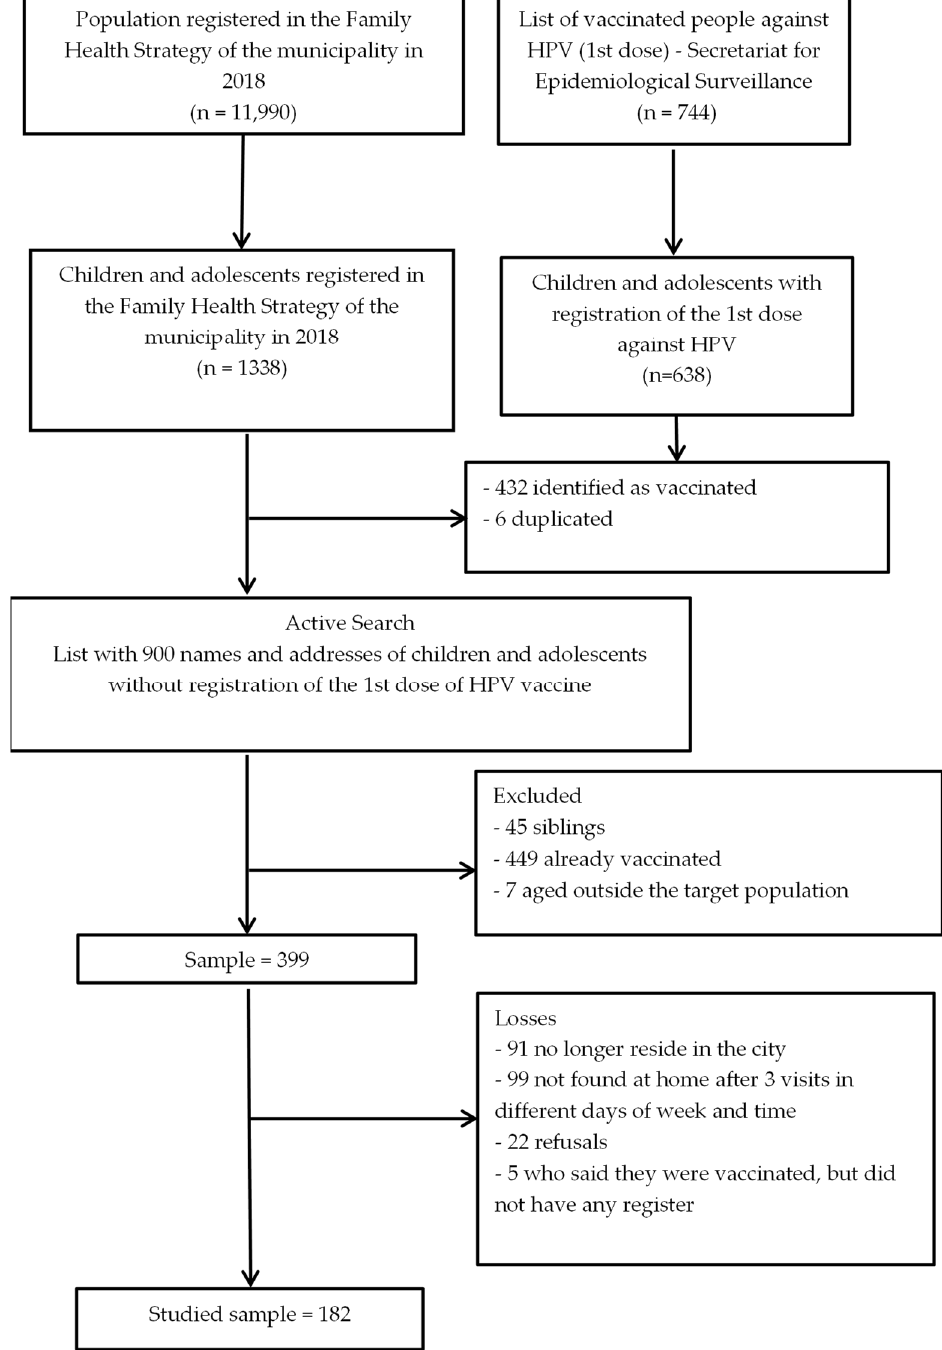
Figure 1. Flowchart of the sample selection process.